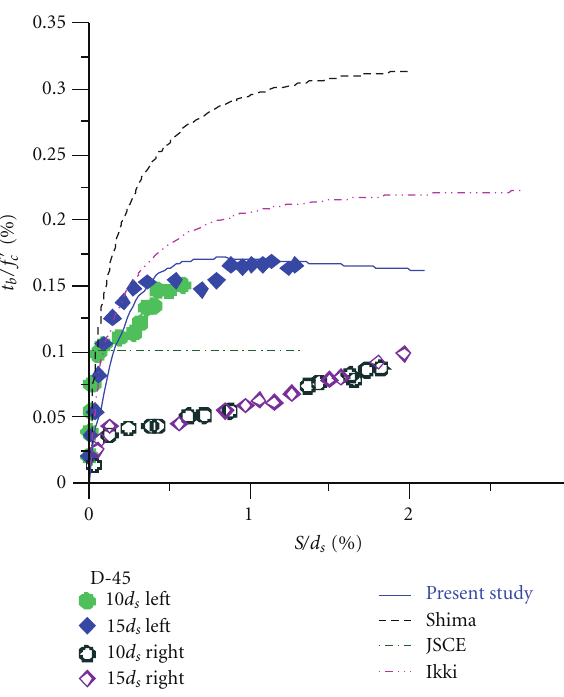
Figure 15: Bond stress-slip relationship of D-30 specimen. Figure 16: Bond stress-slip relationship of D-45